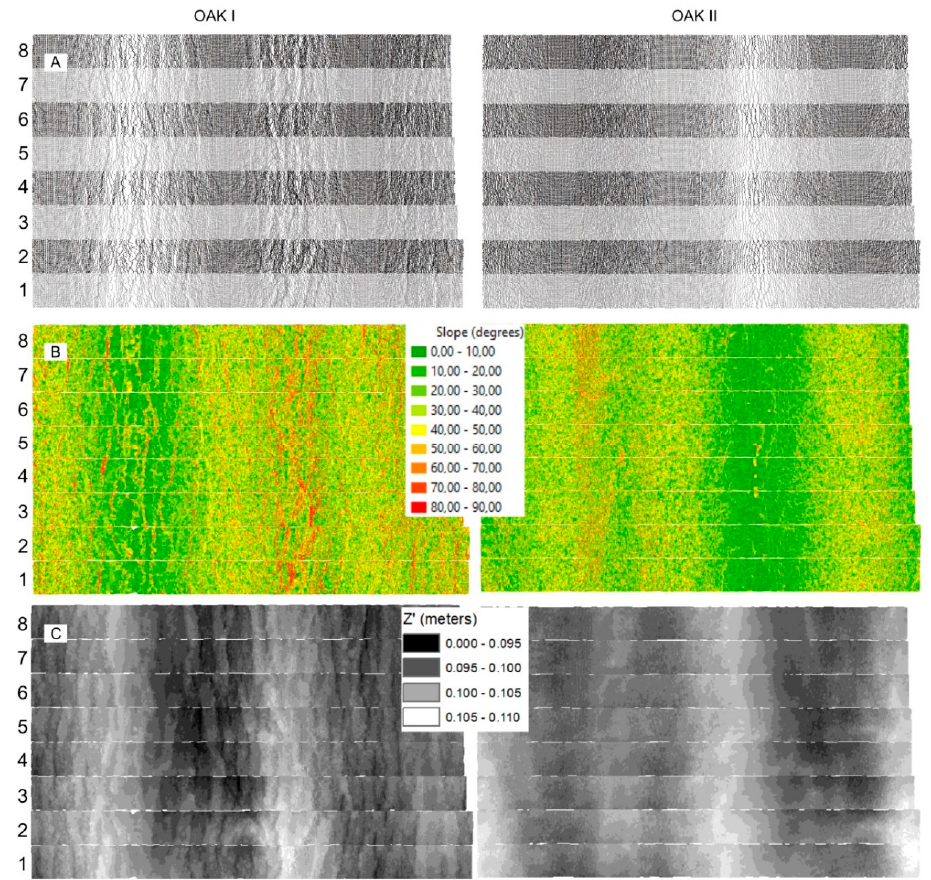
Figure 5. ( A ) transformed point cloud; ( B ) triangulated irregular network; ( C ) Bark height factor ( BHF ) of Oak I and Oak II samples.